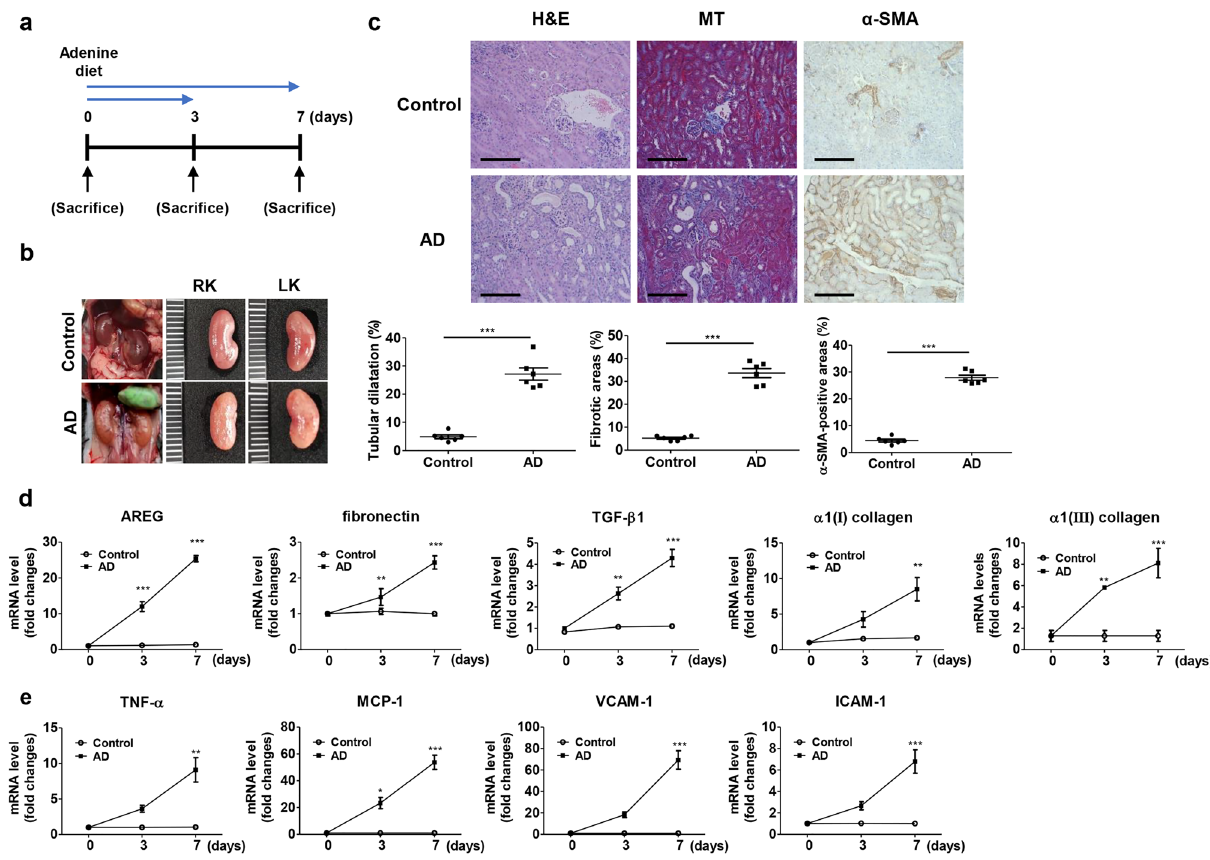
Figure 2. Establishment of AD-induced mice and kinetic analysis of AREG expression, fibrosis-related genes, and inflammatory genes in the kidneys. ( a ) Time scheme for AD-induced mice verification. ( b ) Representative images of kidneys from control or AD-induced mice (harvested seven days after AD). ( c ) Histological analysis by H&E, MT, and IHC staining of control and AD mice. Tubular dilatation, the fibrotic areas, and the α-SMA-positive areas were quantified. Scale bar, 100 μm. ( d ) Kinetics of the expression of AREG, fibronectin, TGF-β1, α1(I) collagen, and α1(III) collagen in the kidneys of AD mice. ( e ) The kinetics of the expression of inflammatory genes (TNF-α and MCP-1) and molecular adhesion genes (VCAM-1 and ICAM- 1) in AD-induced kidneys were measured using real-time qRT-PCR. The values in each panel represent the mean ± SEM of six mice induced by AD. ** p < 0.01, *** p < 0.001 compared to control